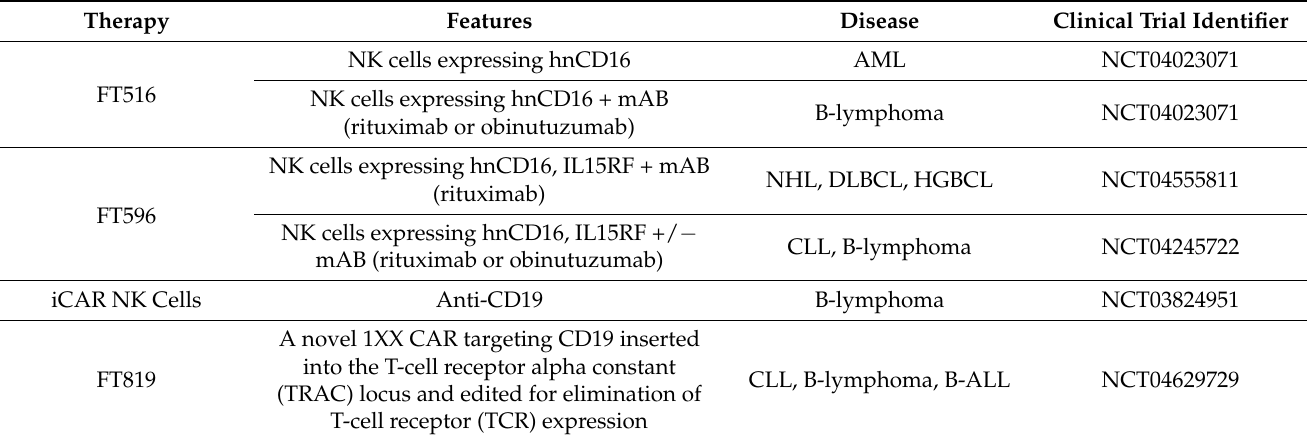
Table 3. Clinical trials of iPSC derived CAR-NK cells in hematological malignancies. Therapy Features Disease Clinical Trial